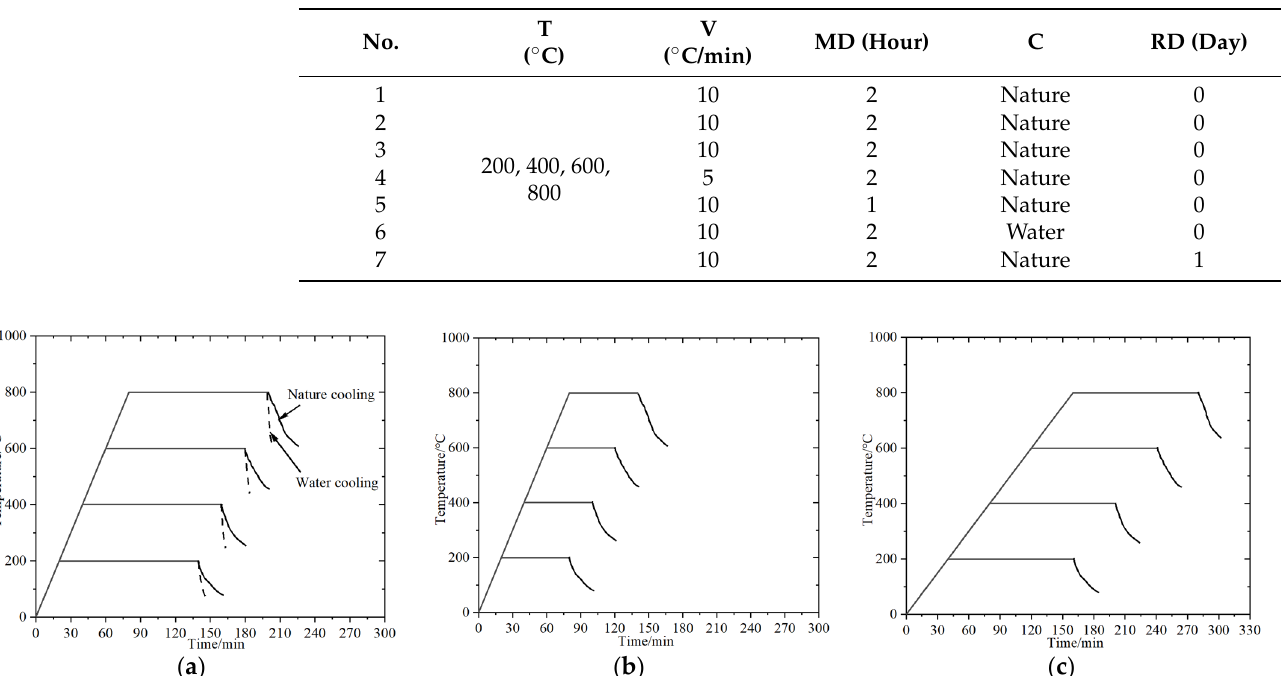
Table 4. High temperature operation mechanism.